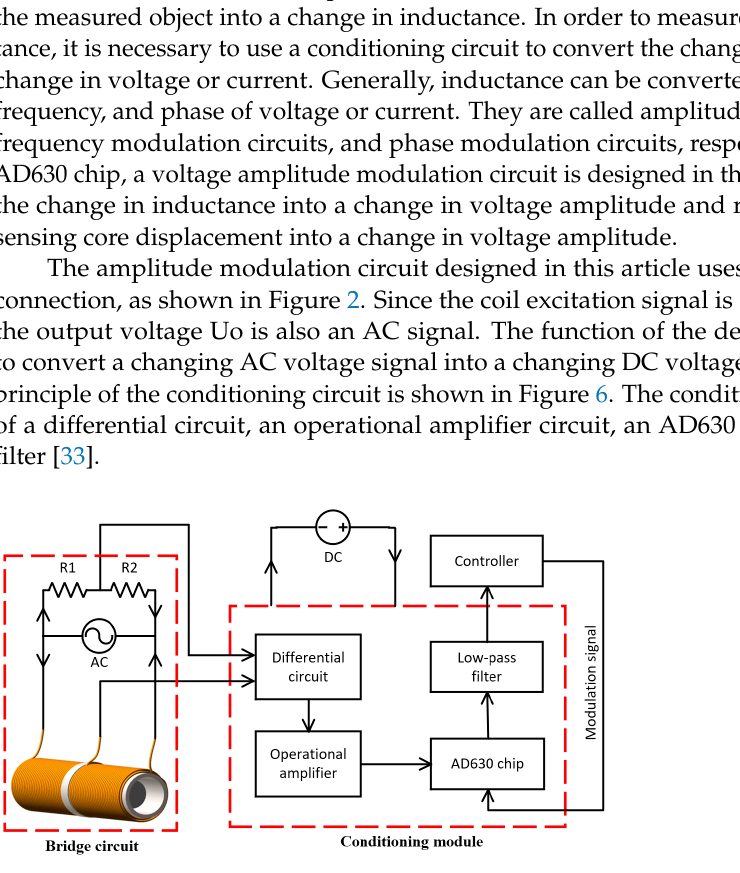
Figure 6. Working principle of the conditioning